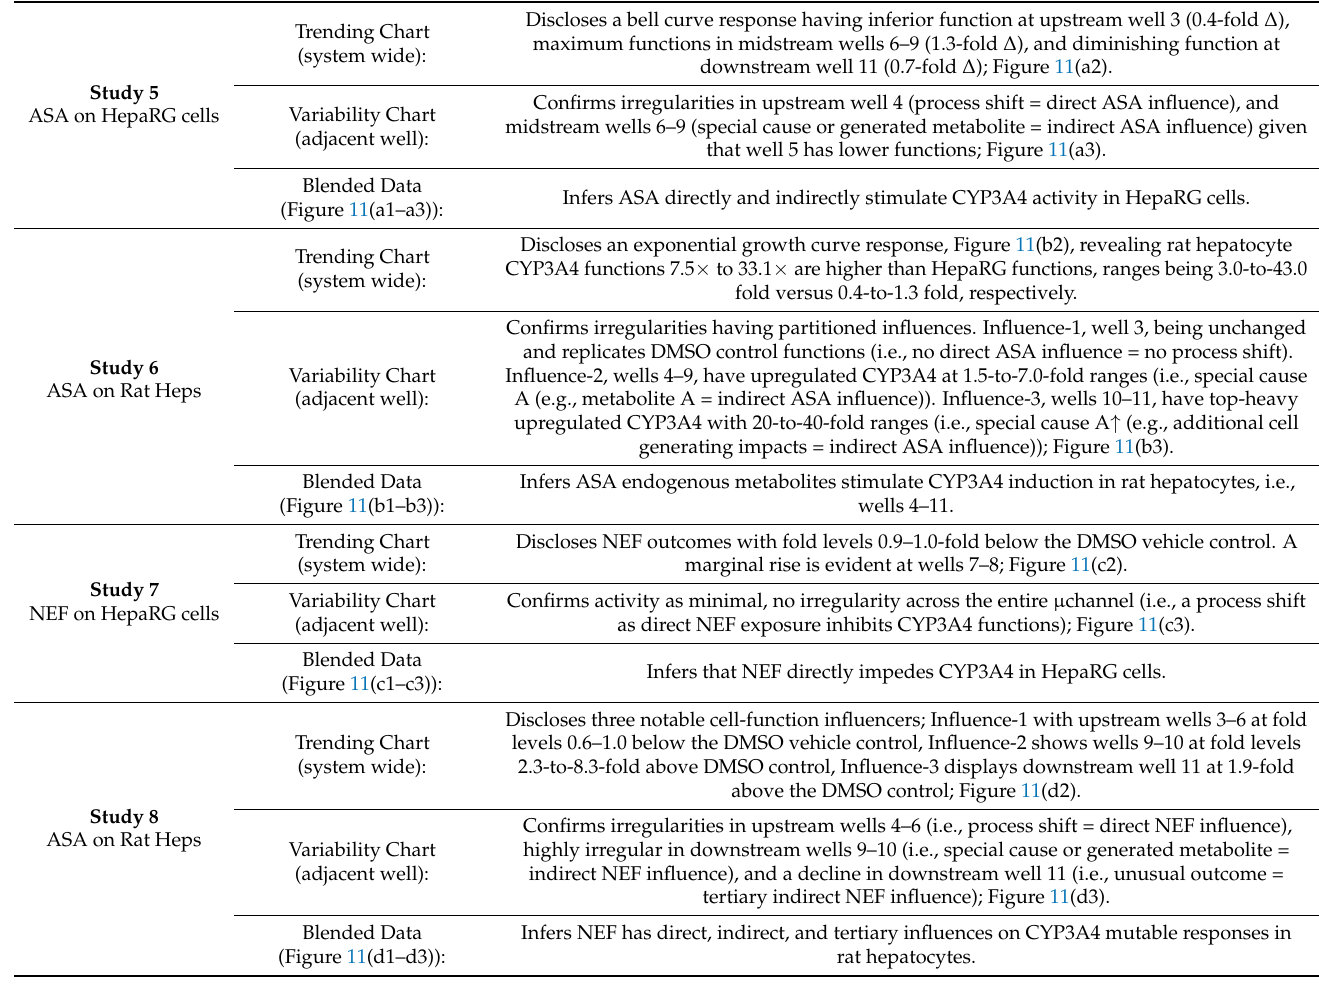
Table 7. Summary of CYP3A4 indicator responses.